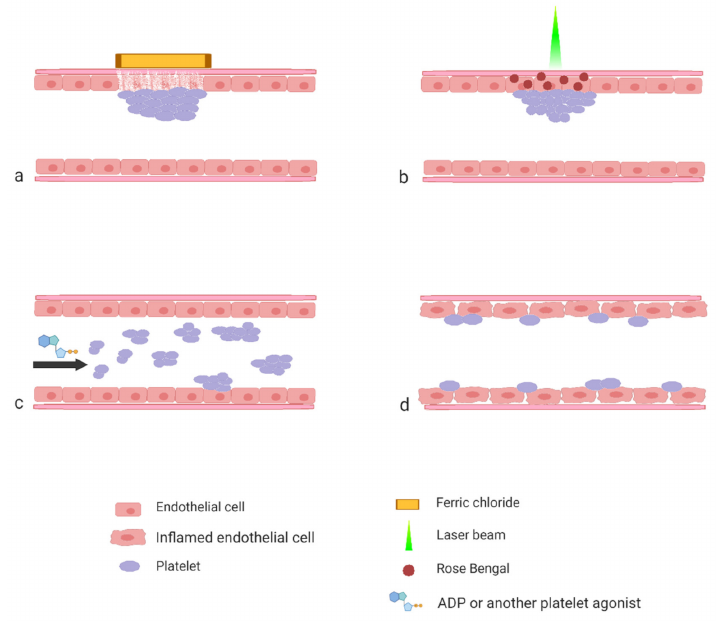
Figure 1. Schematic representation of the experimental models described in the paper. Induction of experimental thrombosis by topical application of FeCl 3 ( a ) or by laser ( b ); induction of experimental thromboembolism by systemic application of platelet agonist ( c ) and interaction of platelets with inflamed endothelial cells ( d